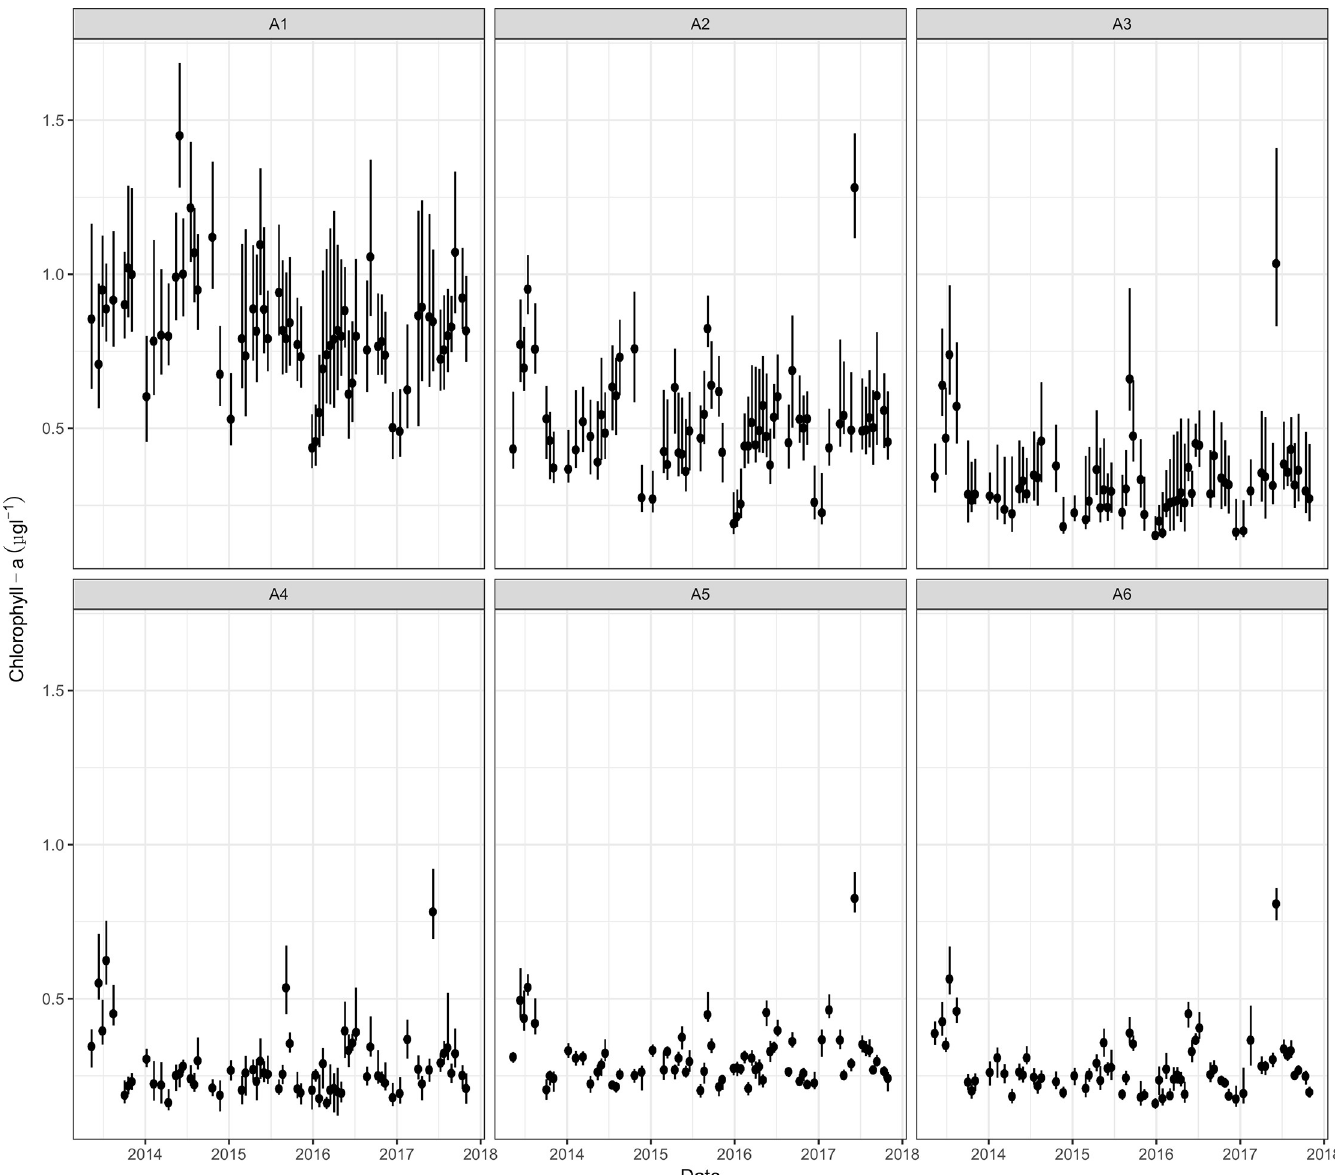
Fig 4. Predictions of Chl-a ( μ g � l -1 ) obtained from the best-fitted model and the Landsat imagery set for the period 2013–2017. Points represent the means; whiskers represent the interquartile ranges. A1-A6 arbitrary areas (see Fig 1 for details).